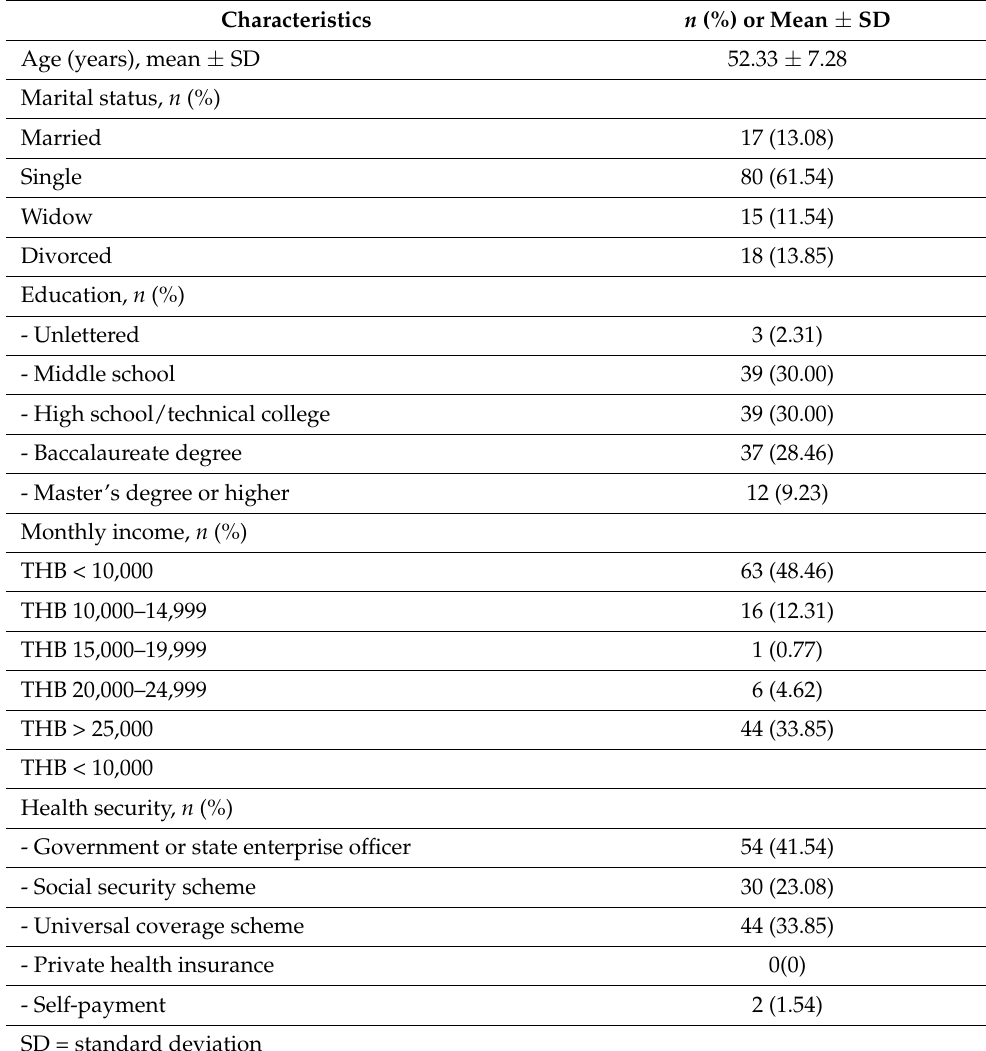
Table 1. Sociodemographic characteristics of the respondents ( n =